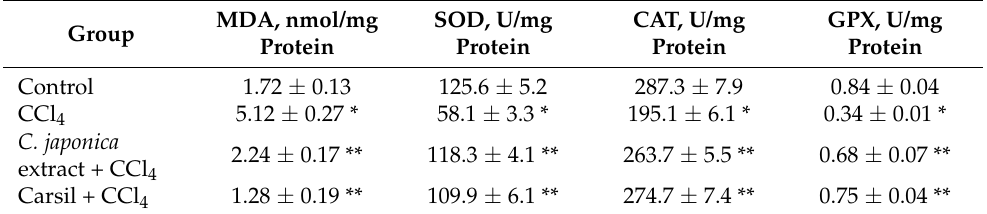
Table 8. Effect of C. japonica extract on rat liver MDA, SOD, CAT and GPX in CCl 4 induced hepato- toxicity in